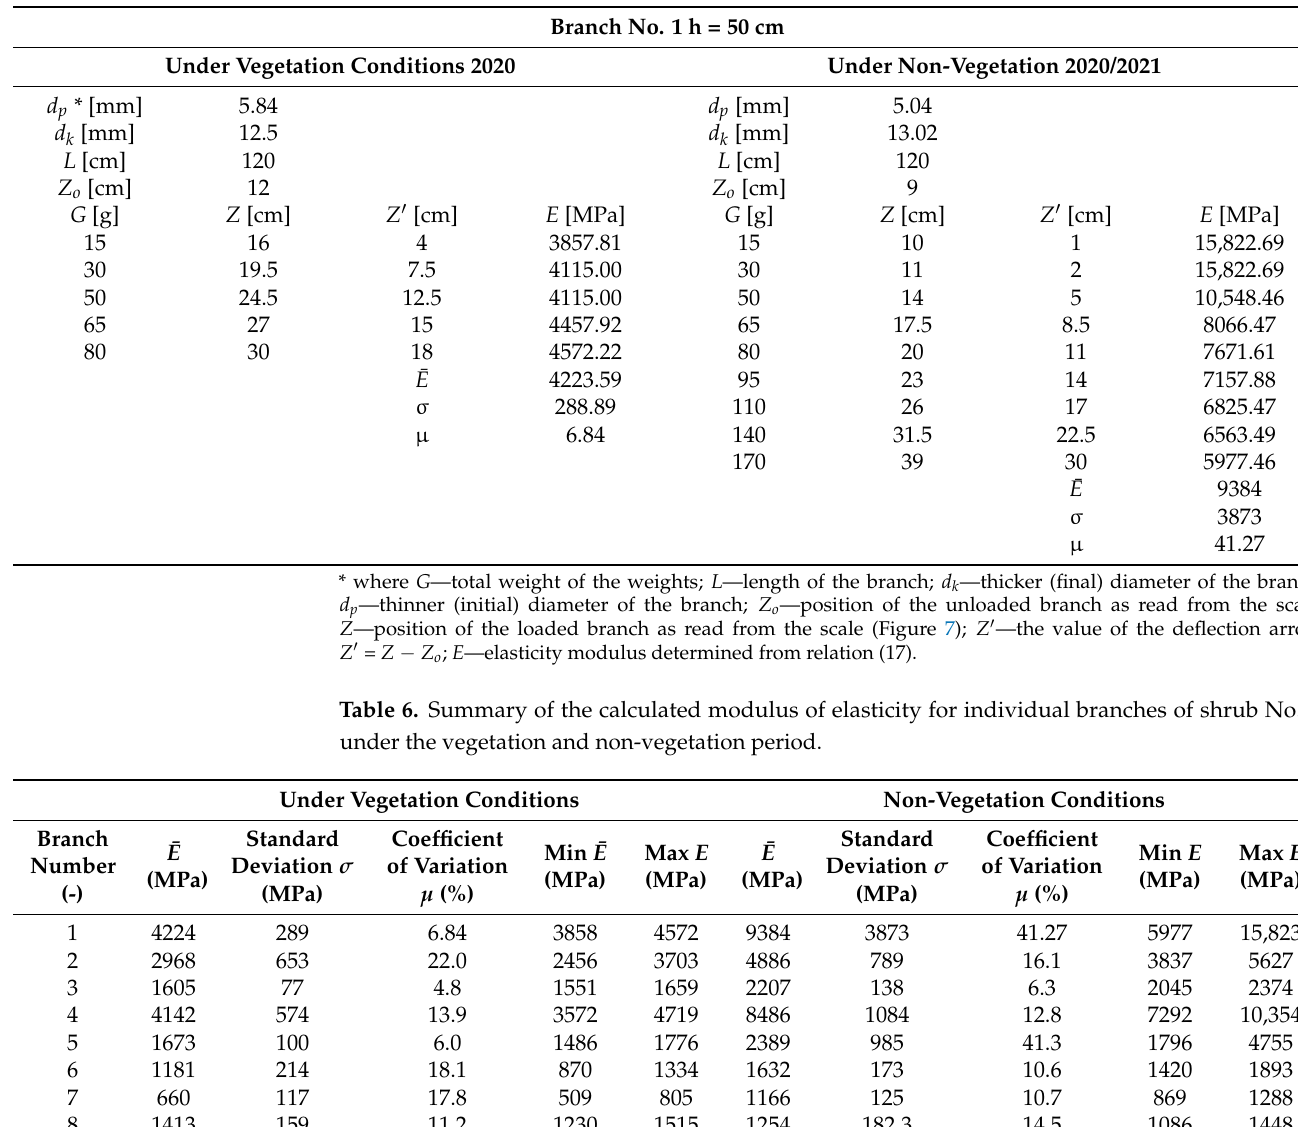
Table 5. Summary of deflection arrow measurements and calculated modulus of elasticity for branch No. 1 of shrub No. 1, for measurements at 50 cm height.